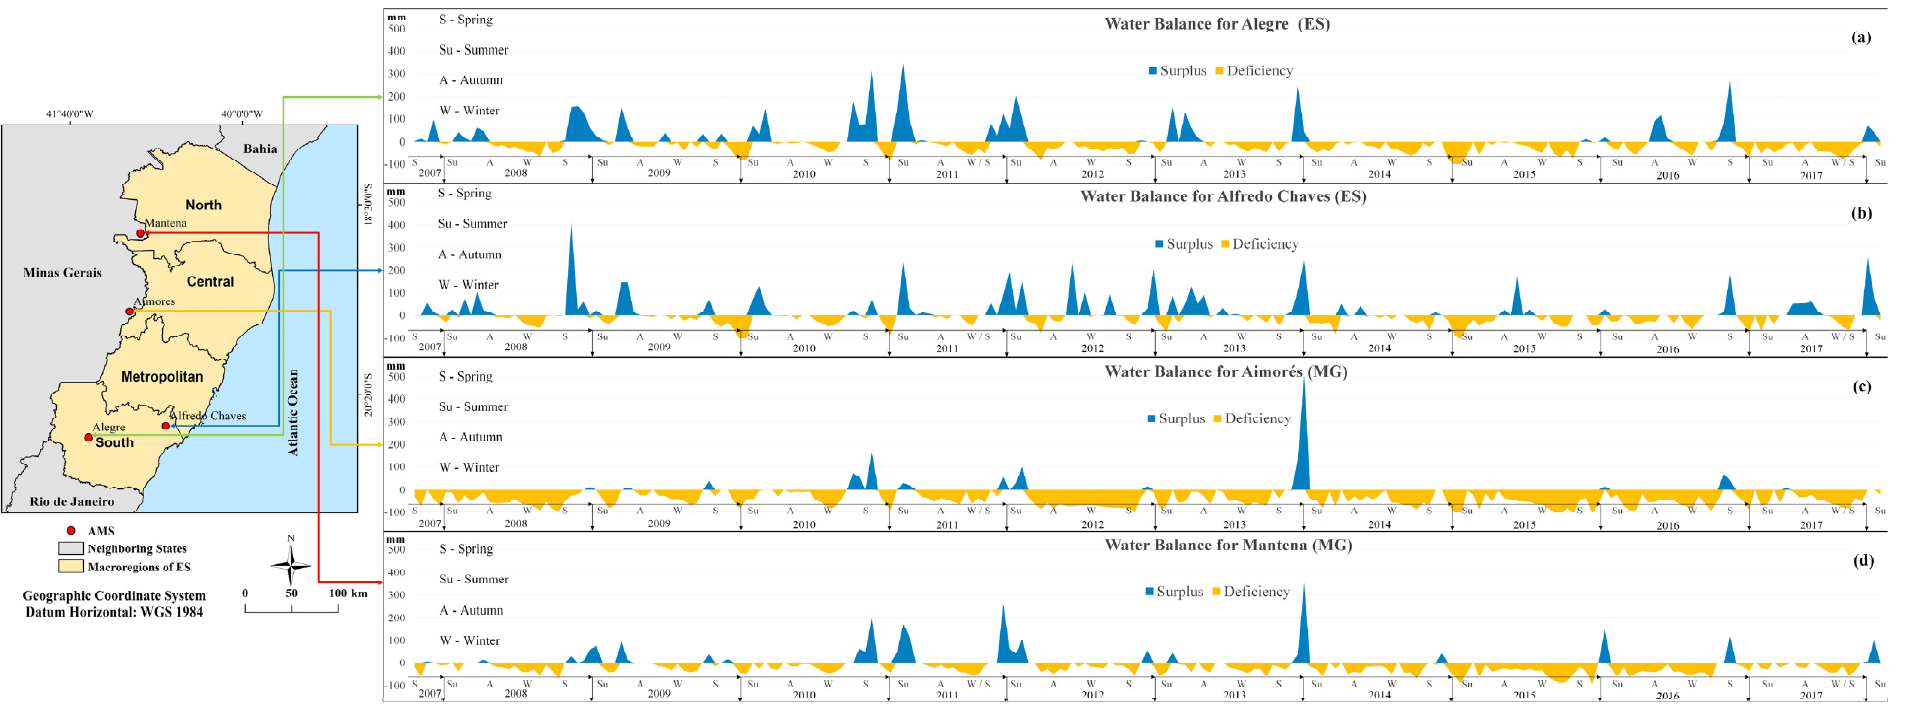
Figure 4. Location of Alegre’s ( a ), Alfredo Chaves’s ( b ), Aimorés’s ( c ), and Mantena’s ( d ) AMS data, where the sequential water balance for each of the four seasons was carried out from 2008 to 2017.